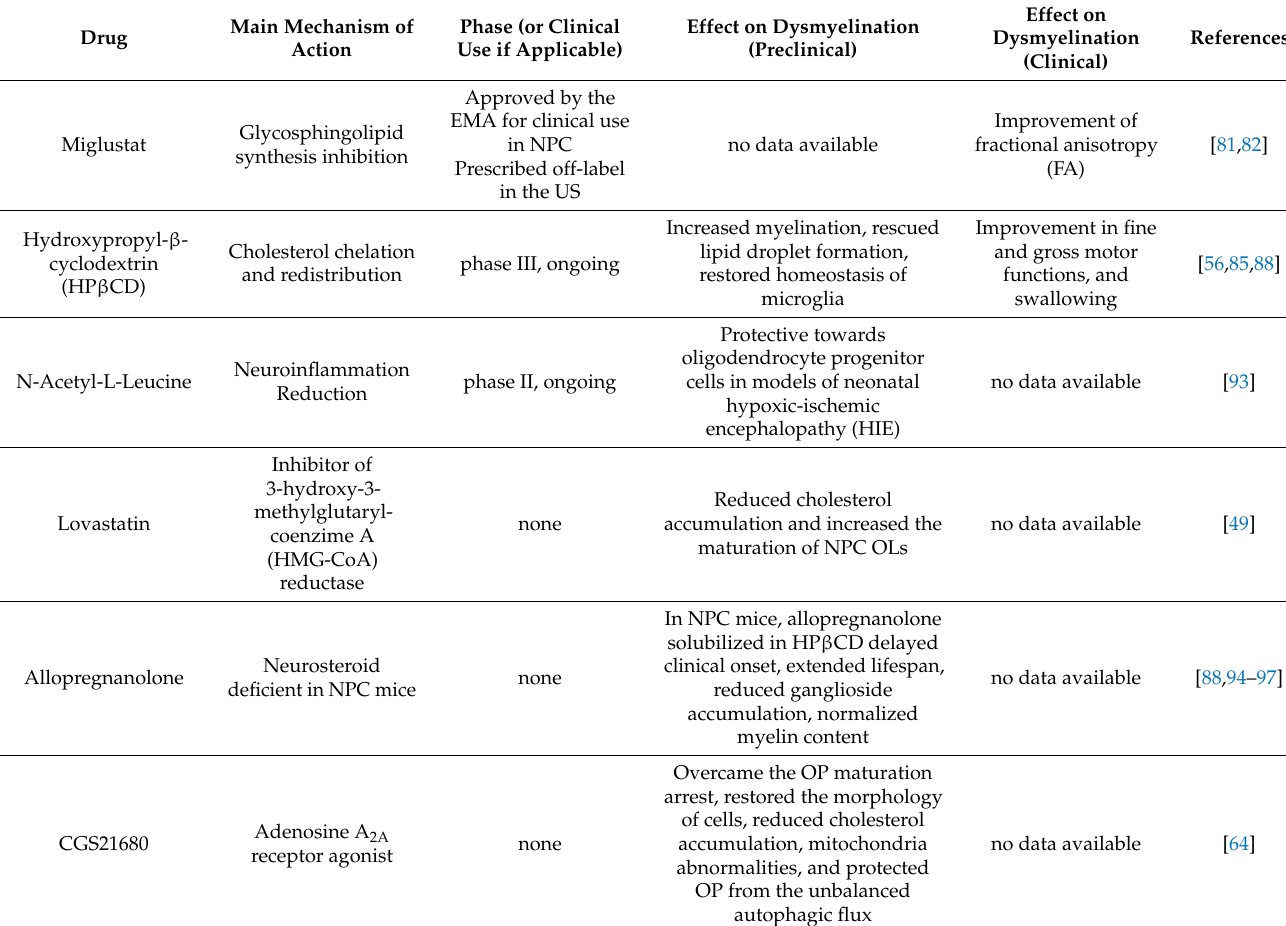
Table 2. Drugs evaluated in NPC and their effects on